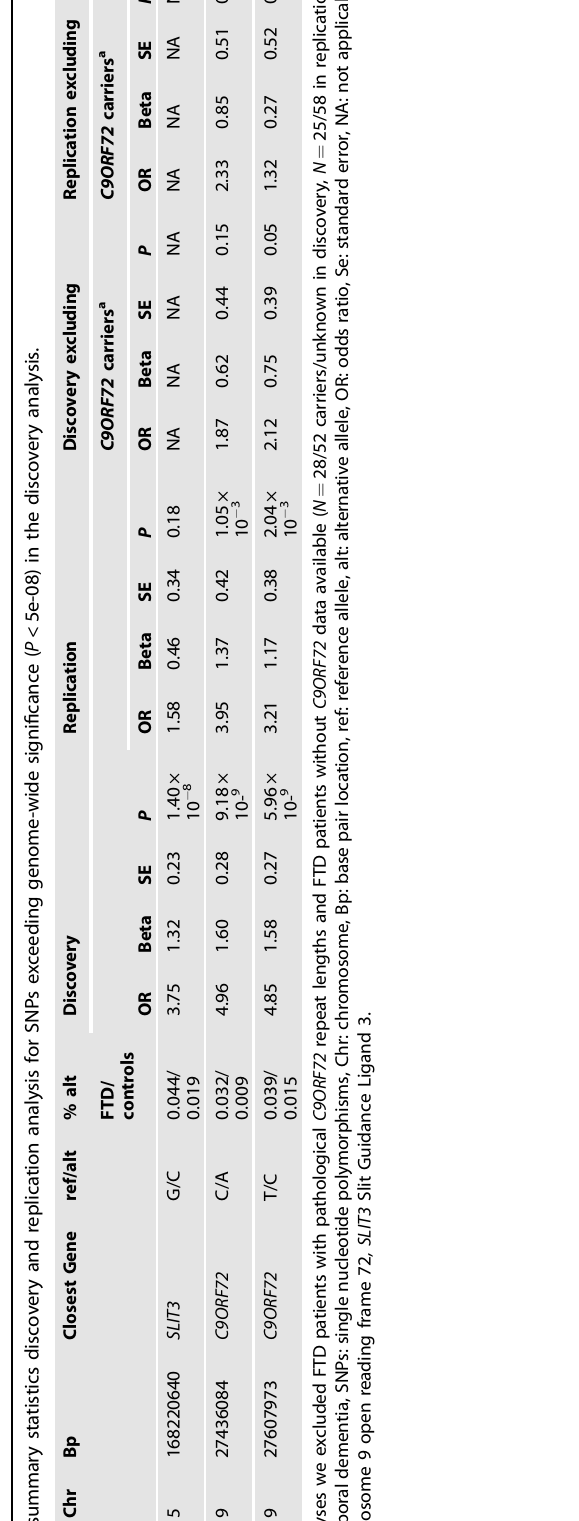
10 − 14 ) (Table S6). No other traits showed signi fi cant associations with the variants. The ADC also includes subjects diagnosed with other types of dementia and mild cognitive impairment ( N = 2543). From these samples, we selected 58 non-related carriers of the FTD risk alleles rs117204439-C and rs14721183-A of European ancestry. We found that four of these 58 risk allele carriers had a pathological C9ORF72 repeat expansion. The diagnoses of the patients were diverse including vascular dementia, a psychiatric diagnosis, mild cognitive impairment, and a postponed diagnosis. C9ORF72 risk alleles associate with intermediate repeat length in haplotype analysis C9ORF72 repeat lengths were measured in a total of 1578 subjects from the ADC cohort, of whom 1327 had SNP-array data available. We excluded 104 individuals with a non-European ancestry and 23 individuals that were related (IBS > 0.2) to each other, leaving N = 1200 individuals for the haplotype analysis (Table S7). We attempted phasing C9ORF72 repeat lengths to haplotypes in all N = 1200 participants (see Methods section and Figs. S1 and S2). We were able to reliably assign C9ORF 72 lengths to the haplotype for 2352/2400 haplotypes (98%). These include 1743 (74.1%) ancestral non-risk haplotypes, 14 (0.6%) ancestral risk haplotypes, 535 (22.7%) founder non-risk haplotypes, and 60 (2.6%) founder risk haplotypes (Fig. 2). Of all pathological C9ORF72 repeat lengths, 96.8% ( N = 30/31) were mapped to the founder haplotype and one was mapped to the ancestral haplotype. Of the 31 repeat expansion haplotypes, 13 (41.9%) were the founder risk haplotype, 12 (38.7%) the founder non-risk haplotype, and 6 (19.4%, 5 founder and 1 ancestral) could not be assigned to a haplotype (Fig. 2). As the founder risk haplotype was much less prevalent, the C9ORF72 repeat expansion was ~10-times more likely to be on a founder risk haplotype compared to the founder non-risk haplotype. In total, 21.7% of the founder risk haplotypes had pathological C9ORF72 repeat lengths ( N = 13/60) compared to the founder non-risk haplotypes (2.2%, N = 12/535) ( P = 7.70 × 10 − 58 ) (Table S8). Next, we compared the distribution of C9ORF72 repeats in the four haplotypes, excluding haplotypes with a pathological C9ORF72 repeat length (>30 repeat elements). Founder risk haplotypes had a median of 12 repeat elements, which was signi fi cantly higher than the founder non-risk haplotypes (median = 8, P = 1.03 × 10 − 38 ), ancestral risk haplotypes (median = 2, P = 2.35 × 10 − 8 ) and ancestral non-risk haplotypes (median = 2, P = 3.33 × 10 − 245 ) (Table S8 and Fig. 3). DISCUSSION Our fi ndings show that the two variants rs117204439 and rs147211831 tag a C9ORF72 haplotype that is carried by ~4% of the population. This founder risk haplotype greatly increases the risk for a pathological C9ORF72 repeat length, which has been associated with FTD and the related motor neuron disorder ALS. Pathological lengths were ~10-times more likely to be present on this founder risk haplotype than on the founder haplotype without the risk variants. Haplotype analyses showed that the well-known founder haplotype with at least one risk allele had a median of 12 repeats compared to a median of 8 for the founder haplotype without risk alleles. The results of this study imply that an increased number of C9ORF72 repeat units increases the risk of conversion from a non-pathological repeat length to a patholo- gical repeat length during parent-offspring transmissions.